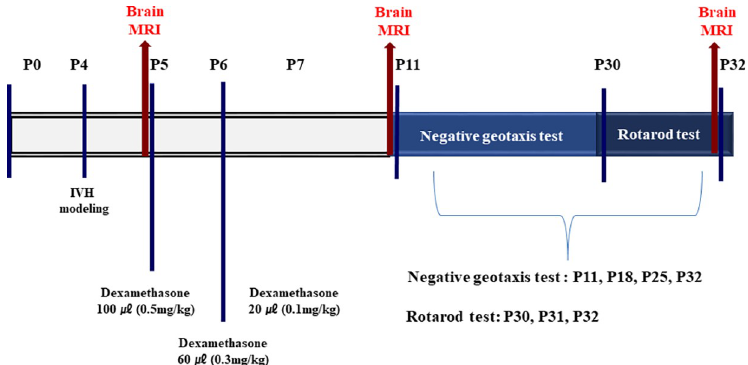
Fig 1. Experimental protocol. MRI refers to magnetic resonance imaging and IVH to intraventricular hemorrhage. Dexamethasone was injected intraperitoneally.